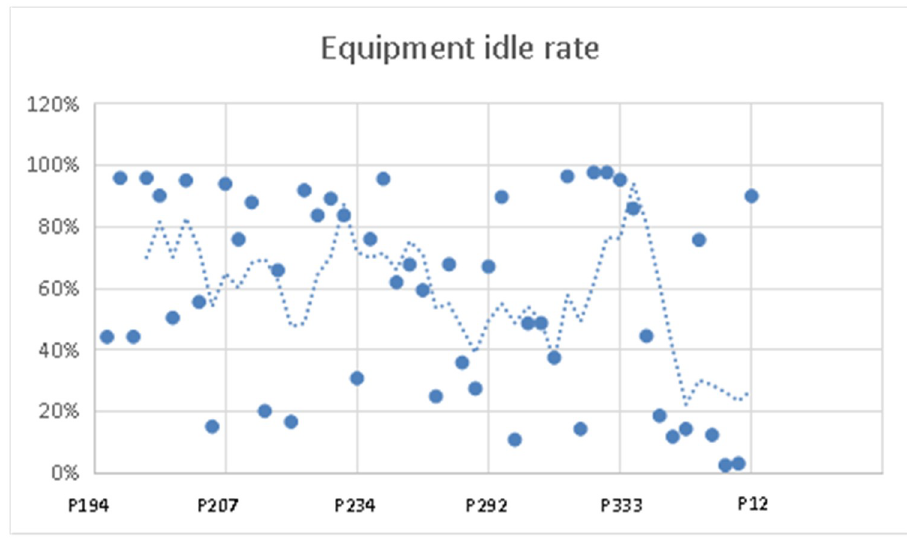
Fig 12. Equipment idle rate scatter plot and fitting curve